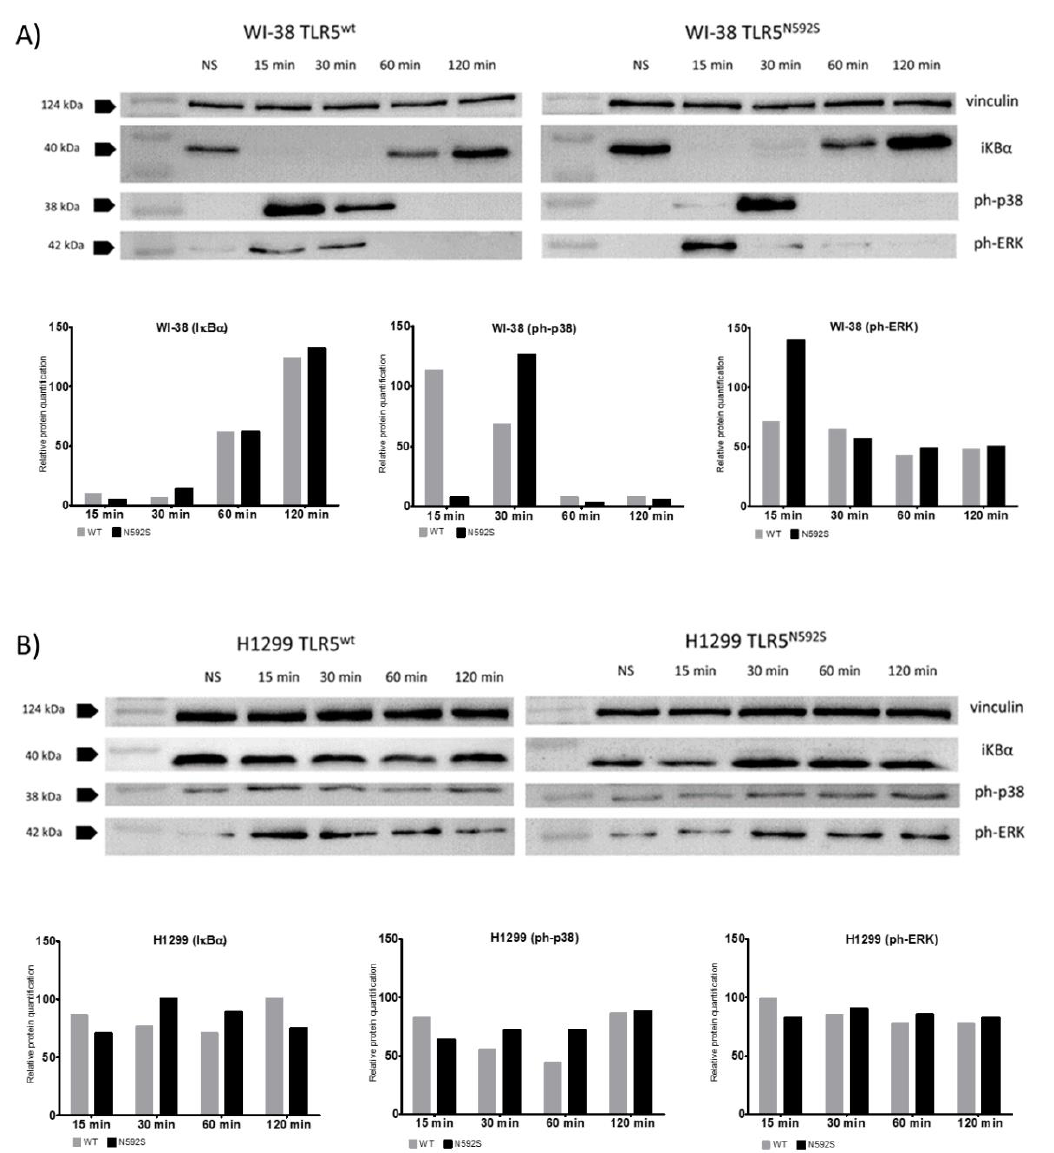
Figure 3. Immunoblot analysis of expression of NF- κB and AP -1 signaling pathways members: pERK, p- p38 and IKBα on ( A ) WI-38 cells infected with TLR5 WT and TLR5 N592S adenoviral constructs and ( B ) H1299 cells infected with TLR5 N592S and TLR5 N592S adenoviral constructs. Cells were infected with an adenoviral vector carrying either TLR5 WT or TLR5 N592S gene and stimulated with a flagellin (50 ng/mL) at five different time points (15, 30, 60, and 120 min). Vinculin was used as endogenous control and for normalization. Biological replicates were made and data shown are representative of two independent